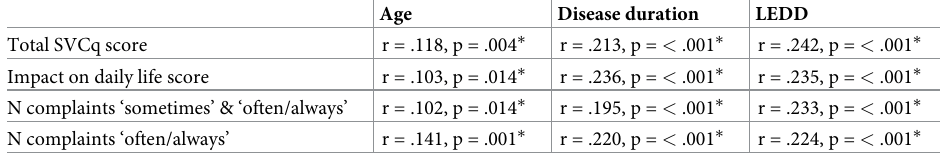
Table 8. Spearman’s correlations between SVCq scores and age, disease duration, and LEDD of people with PD. Age Disease duration LEDD Total SVCq score r = .118, p = .004